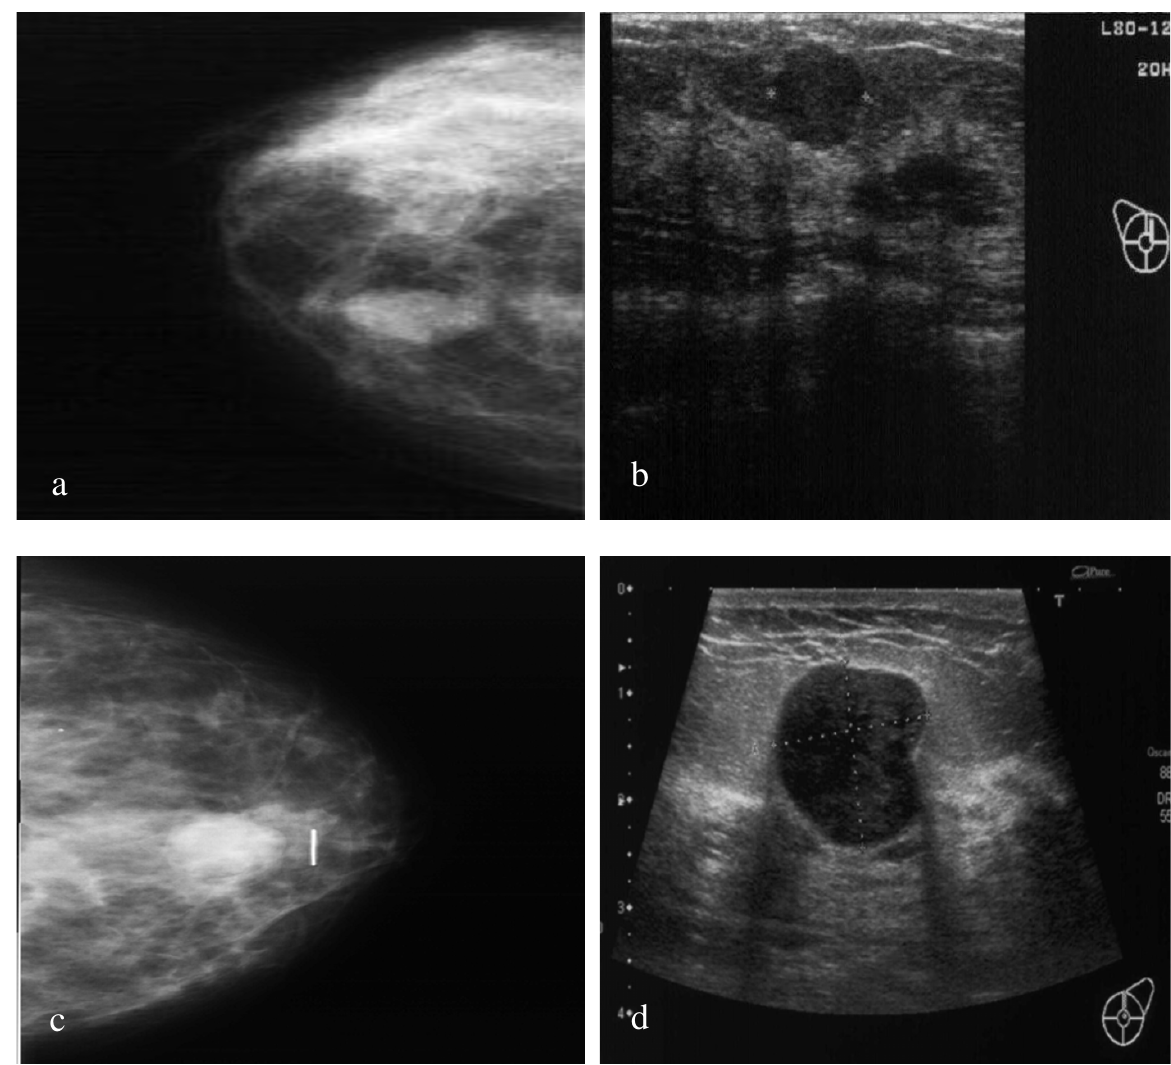
Radiology images from 2 cases presenting with a breast mass . a. Case 1. Mammogram of right breast. b. Case 1. Ultra- sound of right breast. c. Case 2. Mammogram of left breast. d. Case 2. Ultrasound of left